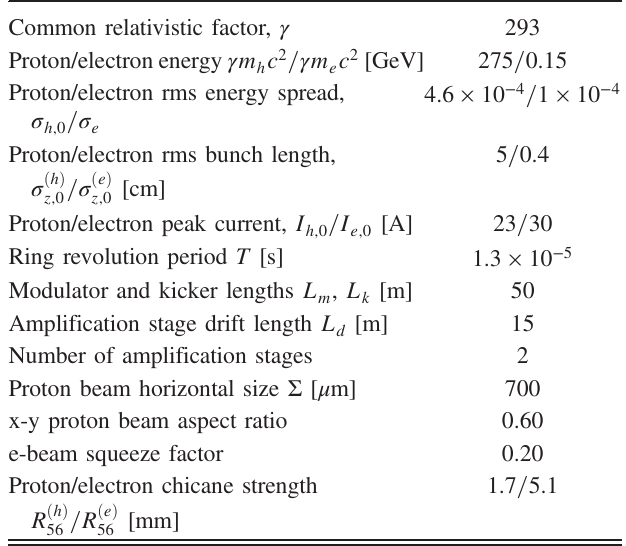
TABLE I. Parameters of the eRHIC collider with a hypothetical MBEC